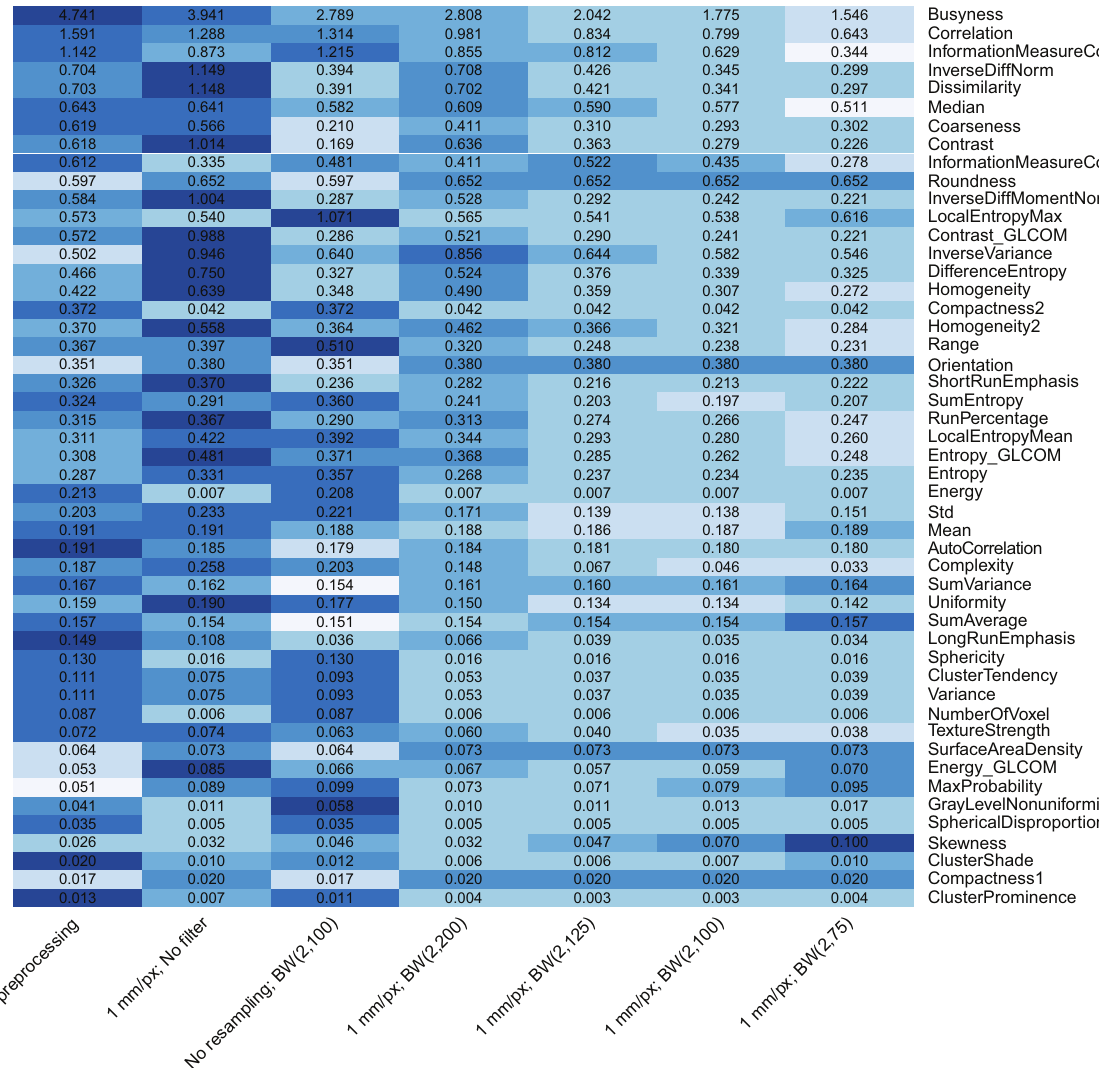
Fig 4. Heat map comparing the scaled variability for the 7 pixel size correction levels for the rubber particle cartridge of the CCR phantom. The features were calculatedfor the phantomfor 17 scans. The color is rescaled on a row-by-row basis; darker colors indicatemore variability. The values in the cells are the scaled variabilityvalues. BW indicatesButterworth; px,